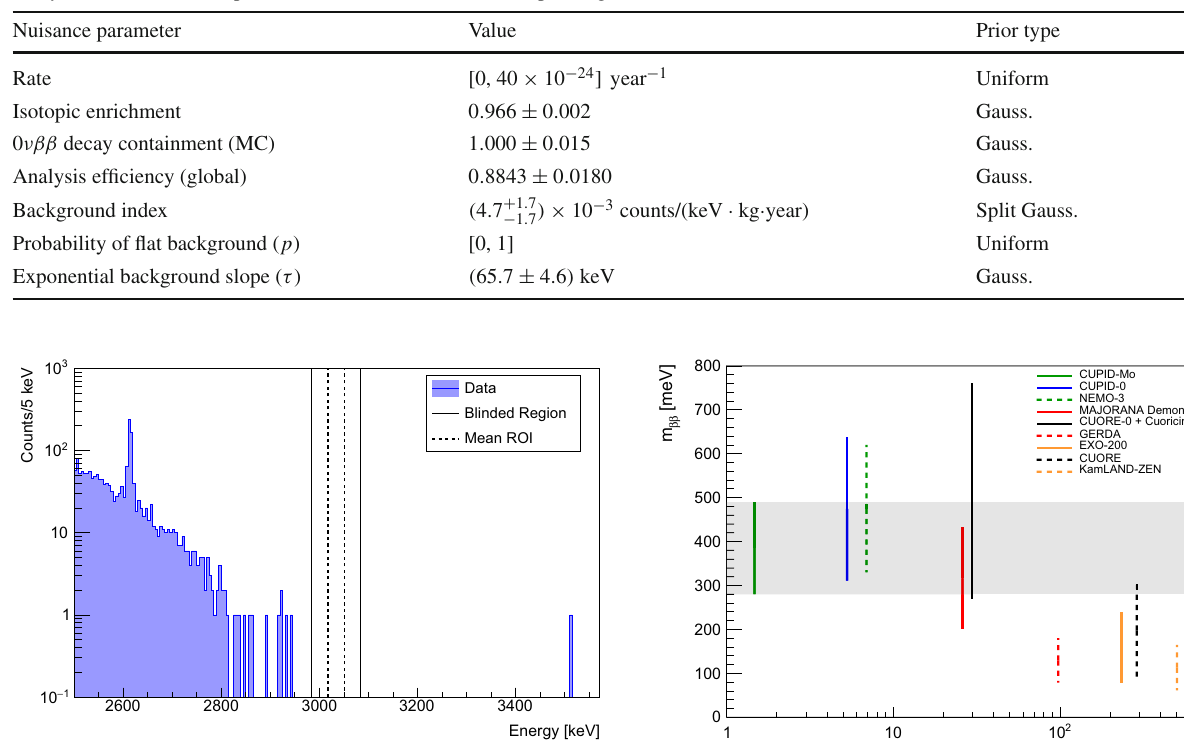
Table 3 Nuisance parameters for the Bayesian model and their central values and prior type. The background index has an asymmetric uncer- tainty and is treated as a split-Gaussian, with each side corresponding